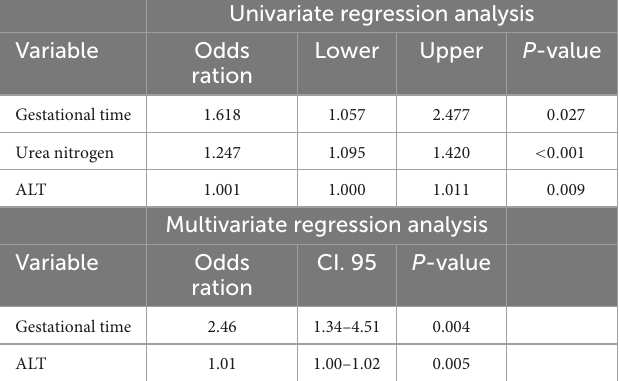
TABLE 4 Positive results of univariate and multivariate regression analysis between good and poor outcome groups. Univariate regression